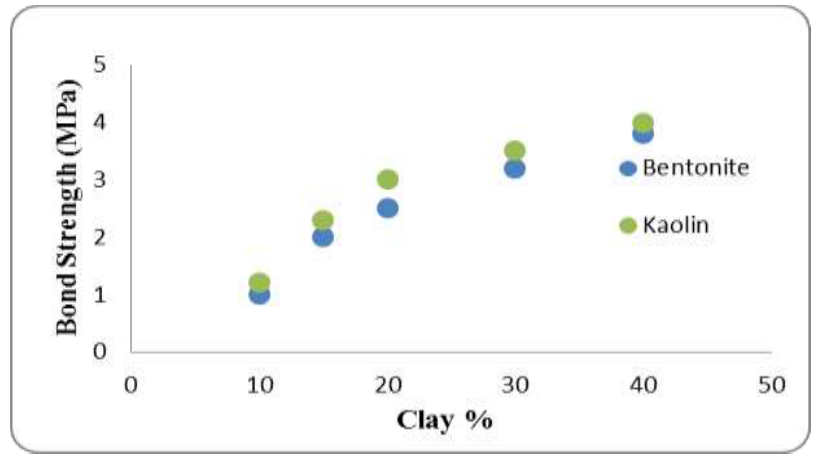
Figure 4: Bond strength for K-mortar and